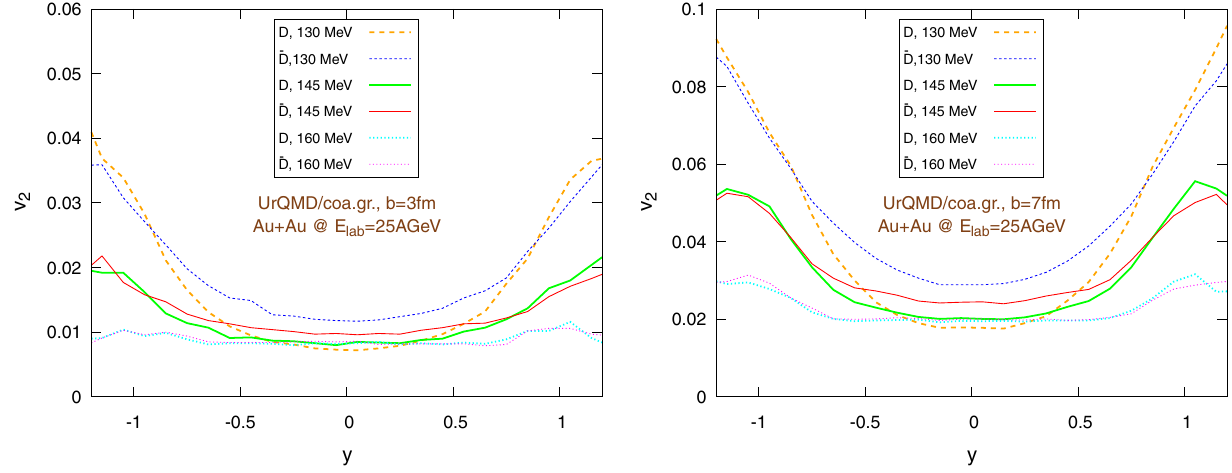
Fig. 21 Elliptic flow of D / ¯ D mesons with respect to rapidity within the UrQMD/coarse-graining approach in Au+Au collisions at E lab = 25 AGeV. We show different hadronization temperatures, with fixed parameters: (cid:23) p = 0 . 05 and